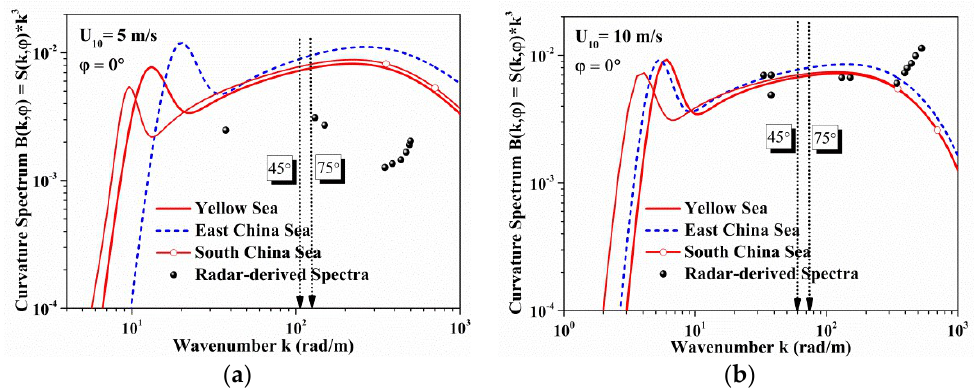
Figure 7. Ocean wave spectrum model considering the ocean environment parameters in different seas: ( a ) Wind speed of 5 m/s; ( b ) Wind speed of 10 m/s. (The vertical dotted lines represent the Bragg microwave wavenumber ranges, and the scattered data stand for the radar-derived spectra).